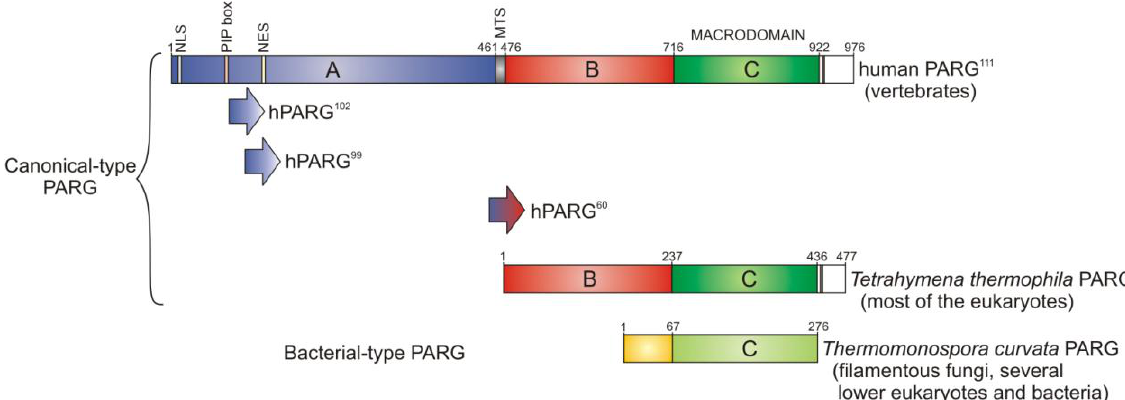
Figure 2. Domain structure of different PARG proteins. The full-length human PARG111 contains an N -terminal regulatory region (A-domain; blue) which includes a nuclear localisation signal (NLS), PCNA binding motif (PIP box) and a nuclear export signal (NES). Full length human PARG also contains a mitochondrial targeting sequence (MTS), a highly structured and conserved B-domain (red), and the essential catalytic macrodomain (C-domain; green). Two shorter isoforms of human PARG, PARG102 and PARG99, lack the NLS and PIP box, while PARG60 lacks the entire regulatory region. Human and Tetrahymena thermophila PARGs represent canonical-type PARGs and share high conservation in their B-domain and macrodomain. Highly divergent bacterial-type PARG represented by Thermomonospora curvata PARG contains the catalytic macrodomain and an N -terminal accessory element (yellow).